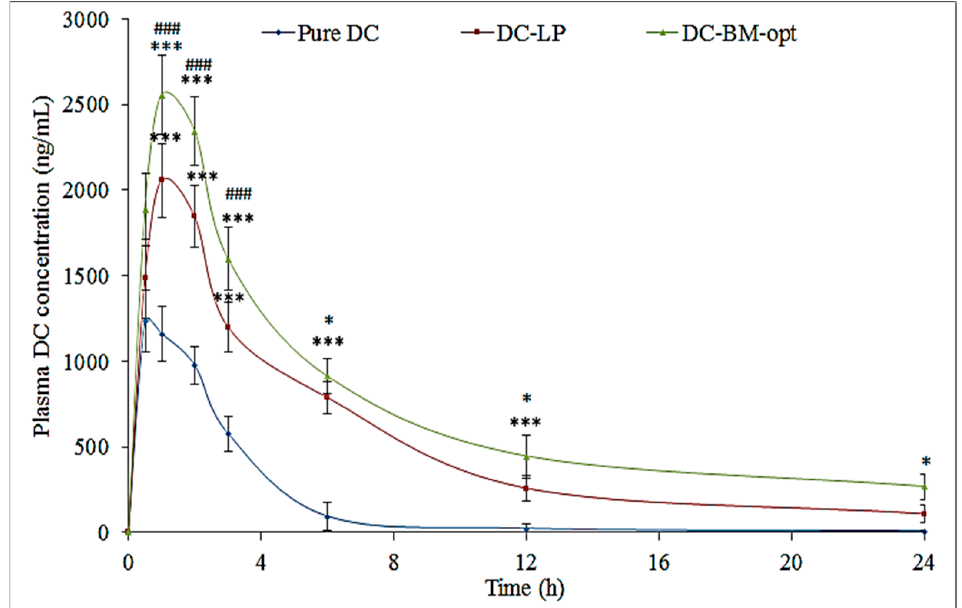
Figure 7. Bioavailability activity of the different treatment groups (pure diclofenac (DC), optimized diclofenac bilosomes (DC-BMs-opt), and diclofenac liposomes (DC-LP)). Study performed with six rats (n = 6) in each group and results shown as mean ± SD. Statistical analysis performed between each group and p < 0.05 considered significant. *** highly significant to pure DC; ### significant to DC- LP; * significant to pure DC and DC-LP.